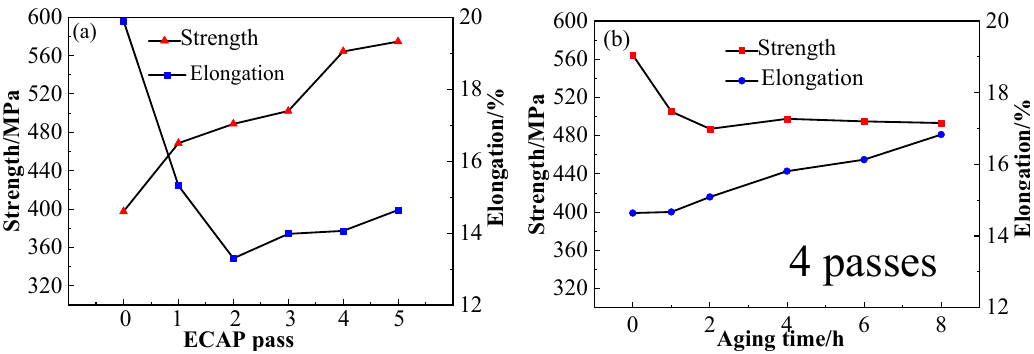
Figure 4. Mechanical properties of Cu–1Cr–0.2Si alloy. ( a ) ECAP deformation. ( b ) Aging treatment at 350 °C after four ECAP passes.